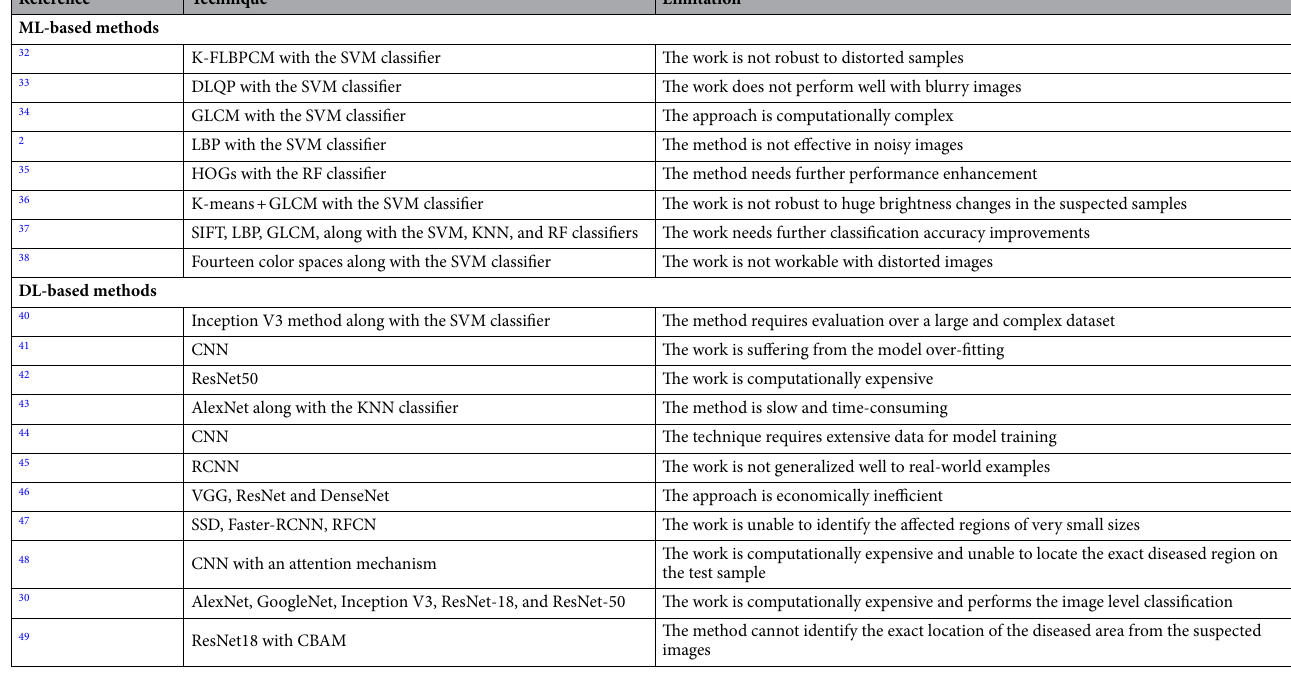
Table 1. Review of existing